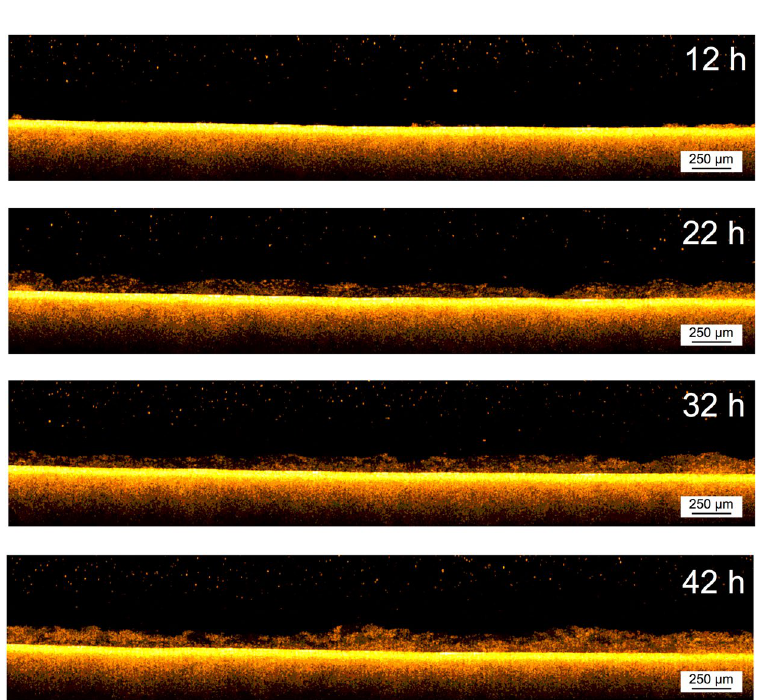
Figure 2. A time-lapse development of early deposition of biomass on a flat sheet membrane in GD-SMBR (from 12 to 42 h) (See Supplementary Video